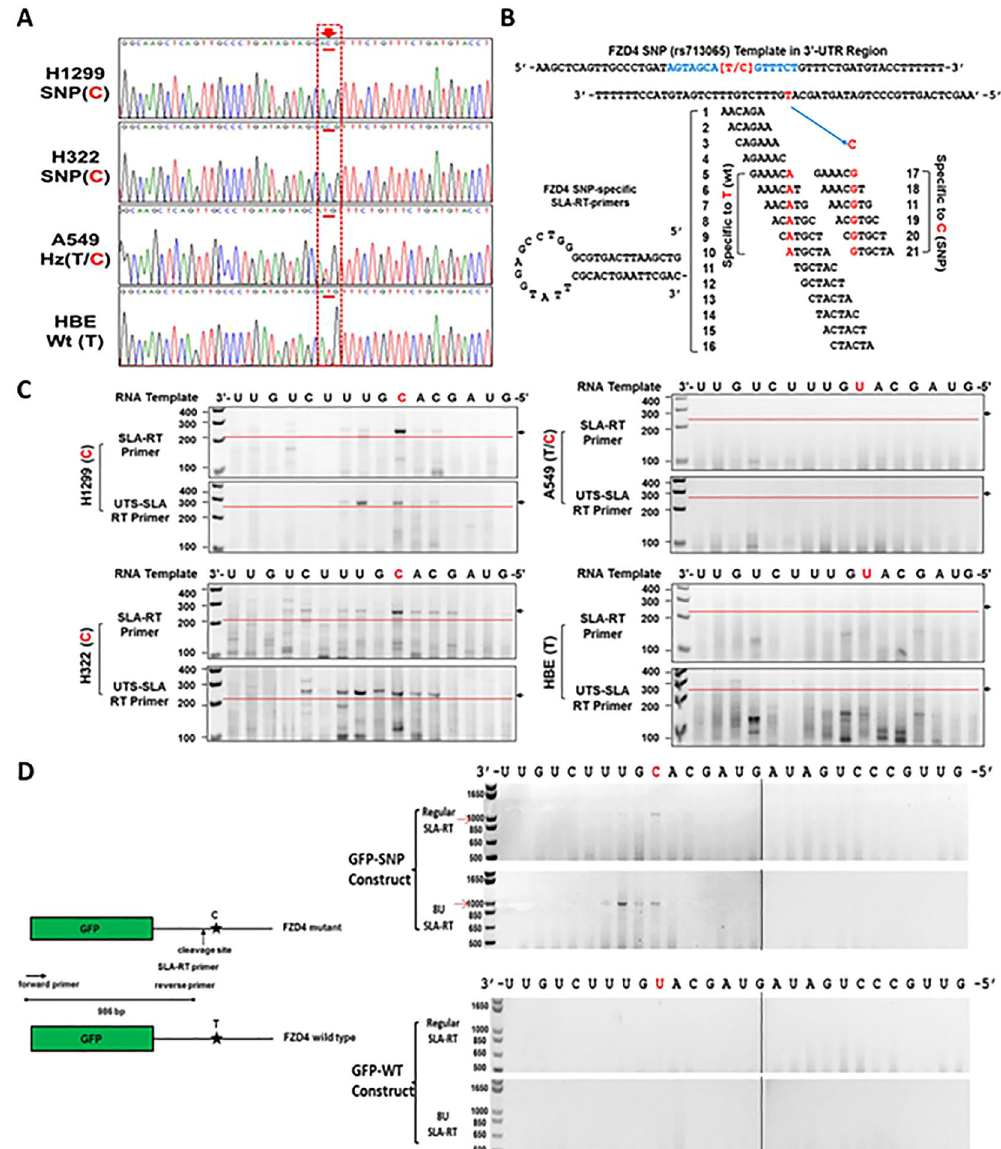
Figure 2. Cleavage and 3 ′ -uridylation of endogenous FZD4 mRNA at miR-SNP loci detected by SLA-RT-PCR. (A) Identification of rs713065 alleles in normal Human Bronchial Epithelial Cell (HBEC) and NSCLC cells by automated DNA sequencing. H1299 and H322 cells carry two copies of the variant C allele (C/C), A549 cells carry one copy of the variant allele (T/C), and HBEC cells are homozygous for the wildtype allele (T/T). (B) FZD4-SNP specific SLA-RT primers. SLA-RT primers were designed to specifically detect the cleavage sites in the 3 ′ UTR of FZD4 mRNA surrounding the SNP locus. 8U-tract-specific (8UTS)-SLA-RT primers corresponding to each SLA-RT primer were also made to detect 3 ′ -uridylation of the cleaved mRNA fragments. (C) Validation of FZD4 mRNA cleavage at specific miRNA binding sites. SLA-RT-PCR detected FZD4 mRNA cleavage and 3 ′ -uridylation in H1299 and H322 cells carrying the C allele, but not in A549 and normal HBEC cells carrying the T allele. The specific SLA-RT-PCR products (ranging in sizes from 236 bp to 220 bp, 3 ′ to 5 ′ on the FZD4 mRNA) were separated on a 2% agarose gel (for full length gel images see supplementary Fig. S2). (D) Differential mRNA cleavage in GFP-SNP-3 ′ UTR and GFP-WT-3 ′ UTR transfected cells. SLA-RT-PCR detected cleaved mRNA fragments of the predicted sizes in GFP-SNP-3 ′ UTR transfected cells, compared with no cleaved mRNA in those transfected with GFP-WT-3 ′ UTR. Gel images were cropped from full length individual gel images shown in supplementary Fig.